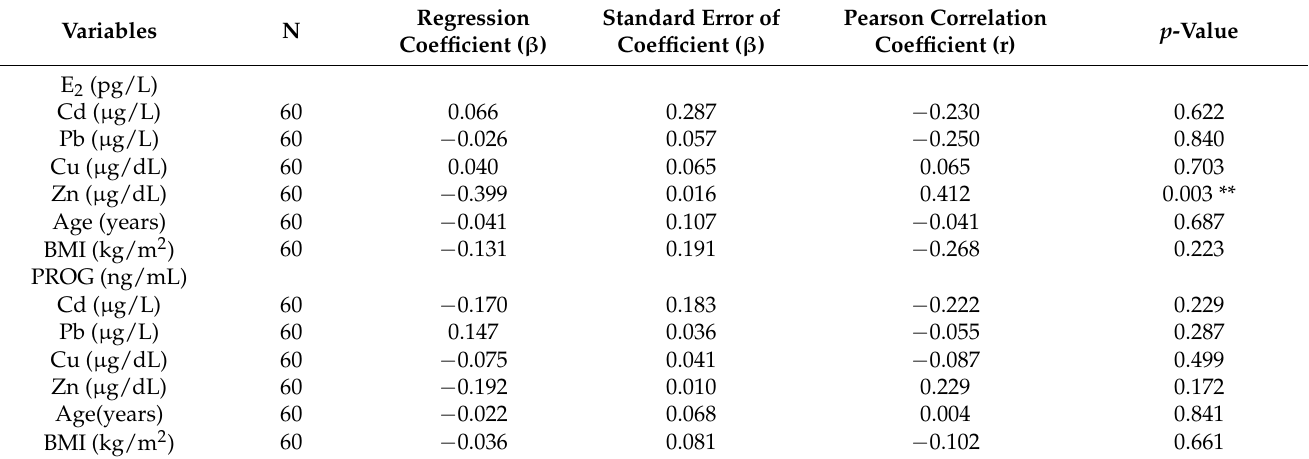
Table 8. Interrelationship of sex hormones with other measured indices.